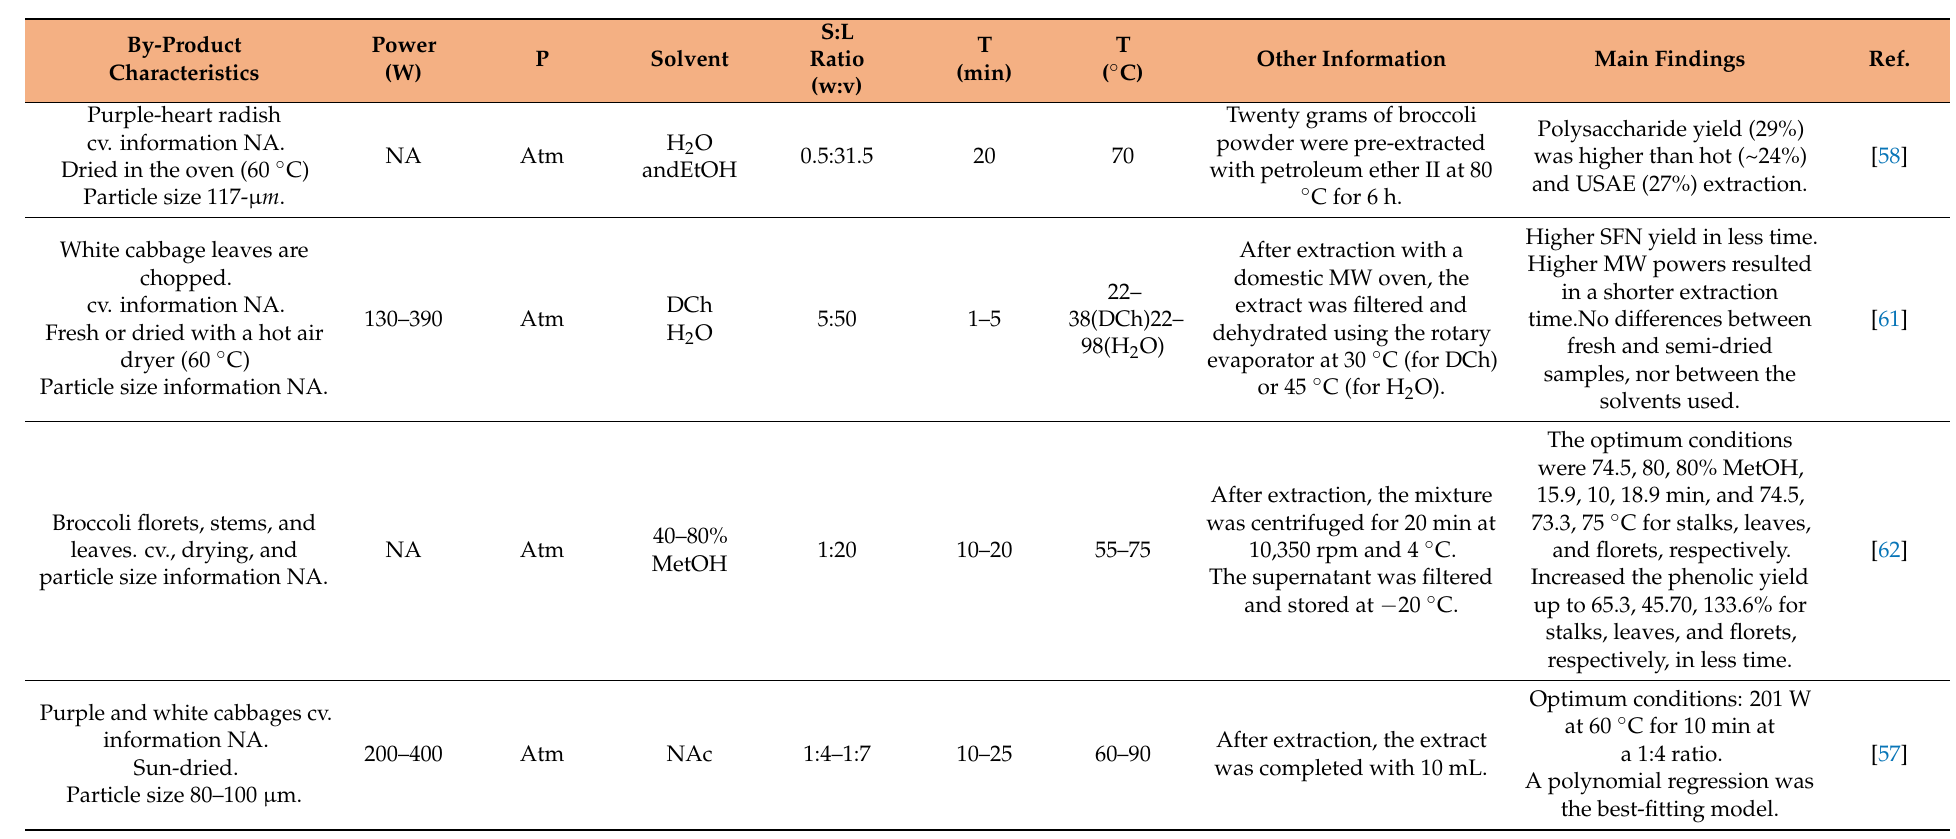
Table 2. Microwave conditions (power parameters, solvent, time, and temperature) for the extraction of bioactive compounds from Brassica by-products. Other Information Main Findings